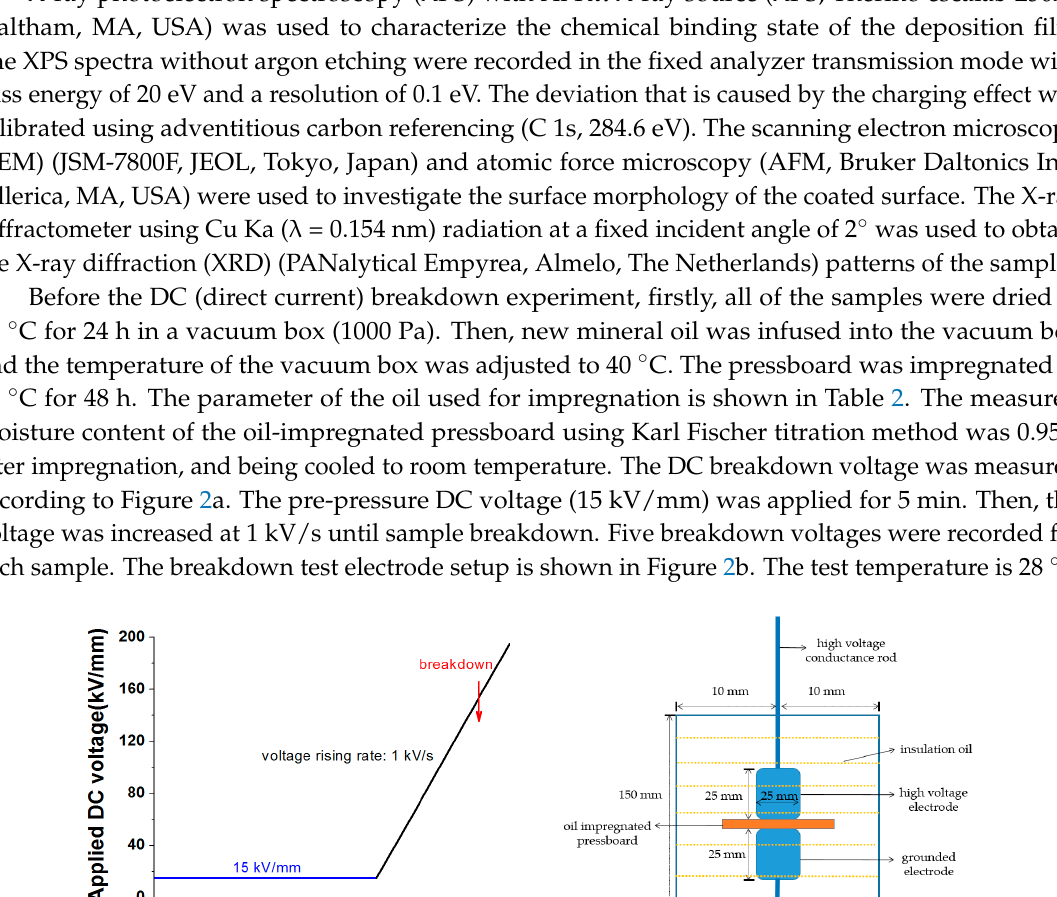
Figure 2. Direct current (DC) breakdown test process and the DC breakdown test electrode setup. ( a ) DC breakdown test process; ( b ) DC breakdown test electrode setup.